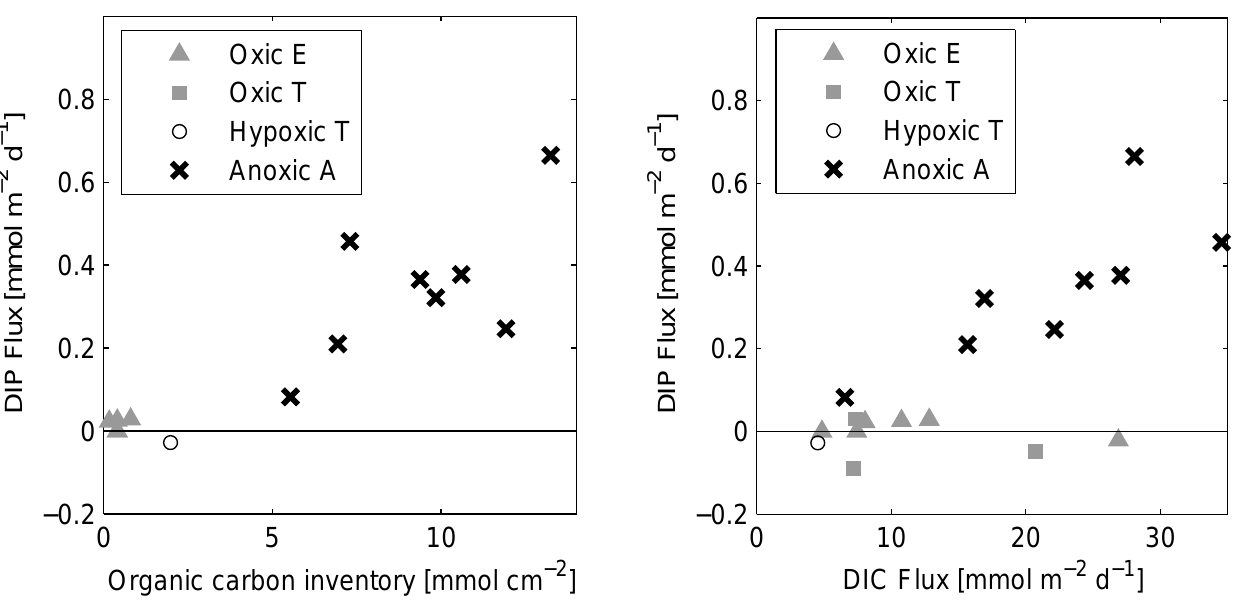
Fig. 10. DIP flux versus DIC flux. Fluxes are presented as mean values for each lander deployment.